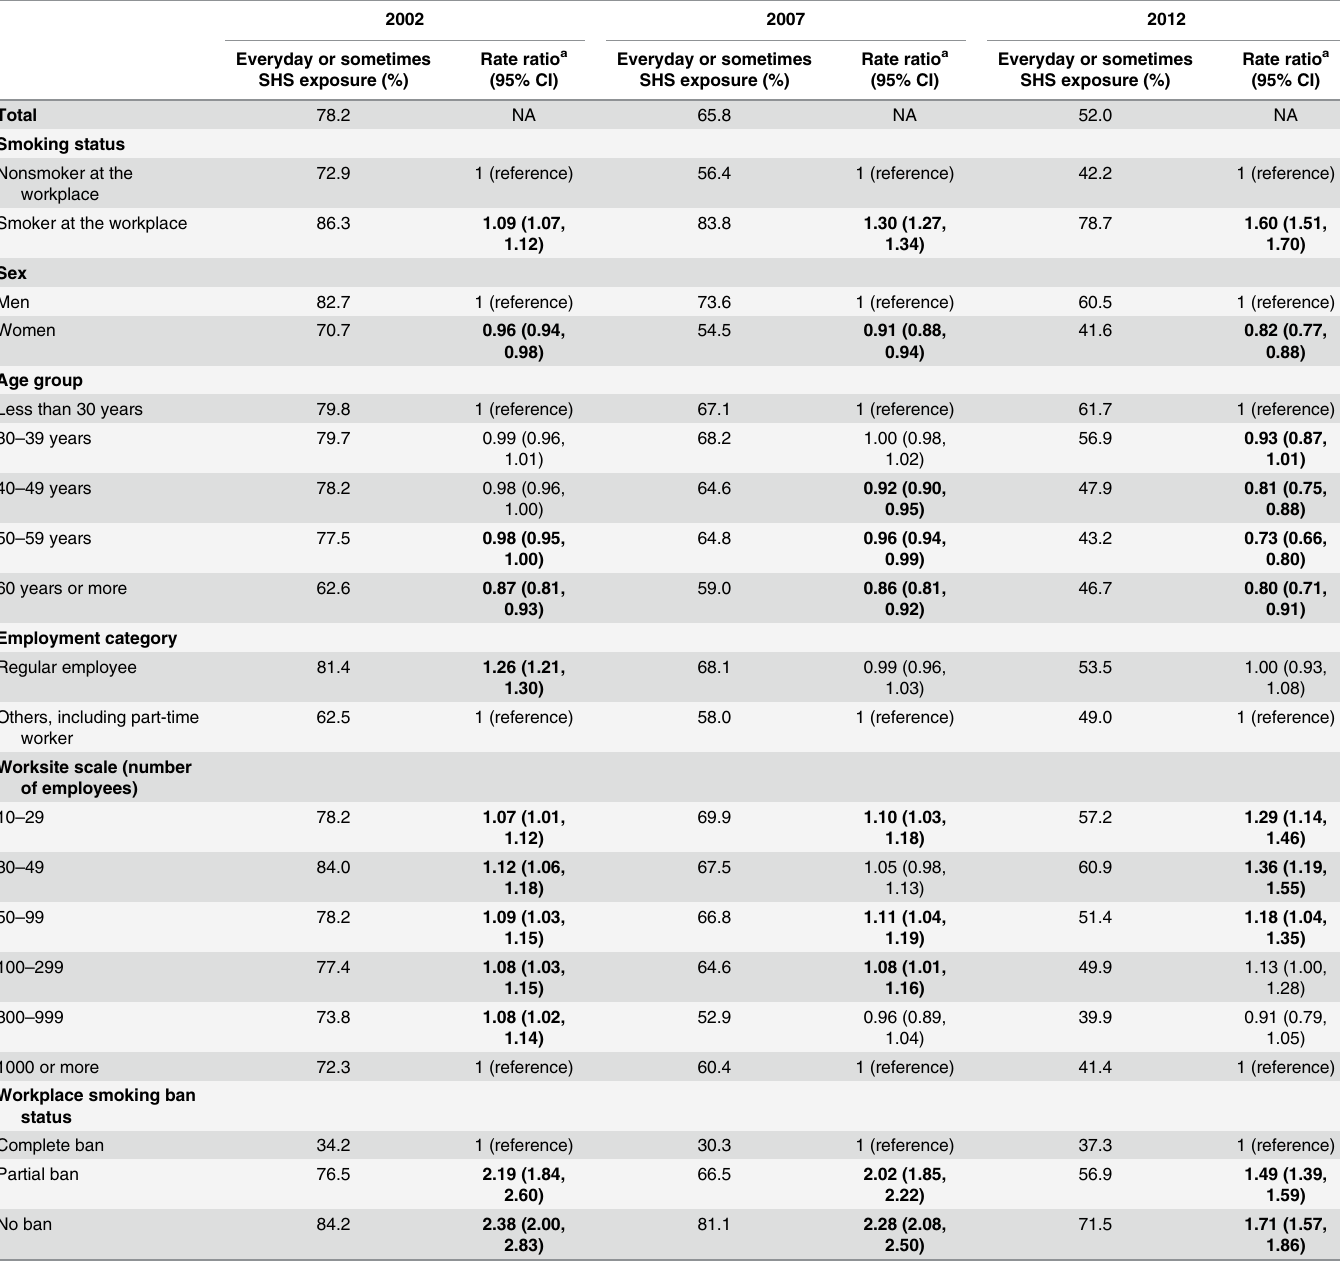
Table 5. Trends in prevalence and rate ratio for workplace SHS exposure from other people (everyday or sometimes) among employees according to characteristics (weighted